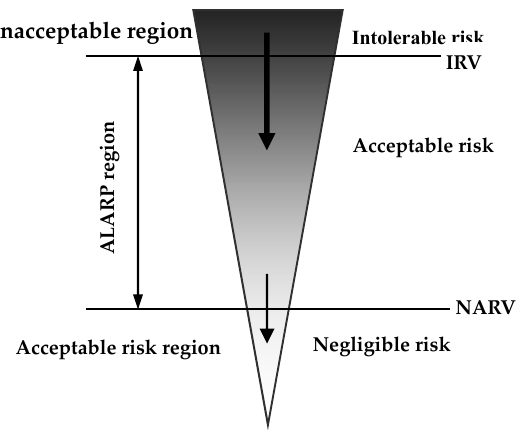
Figure 5. Level of risk and the as low as reasonably practicable (ALARP) region. 336